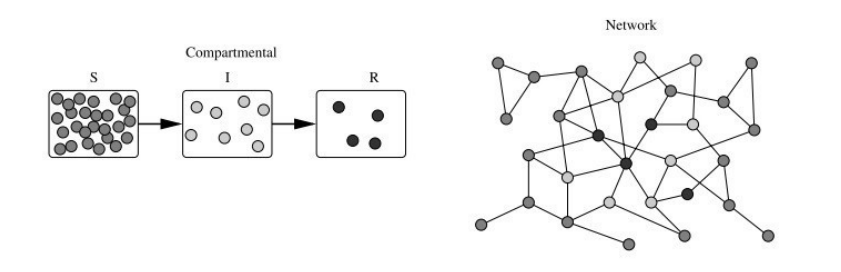
Fig. 4 Homogeneous compartmental model versus heterogeneous contact model. For the compartment model the disease spreads along the arrows (left figure) and in the net model the disease spreads through the edges (right figure) [94]. Diseases affecting interacting populations have been reviewed in